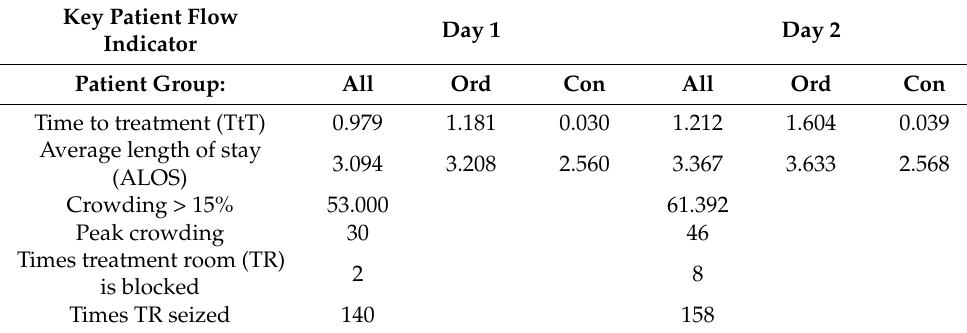
Table 11. Table displaying a subset selection of KPI from